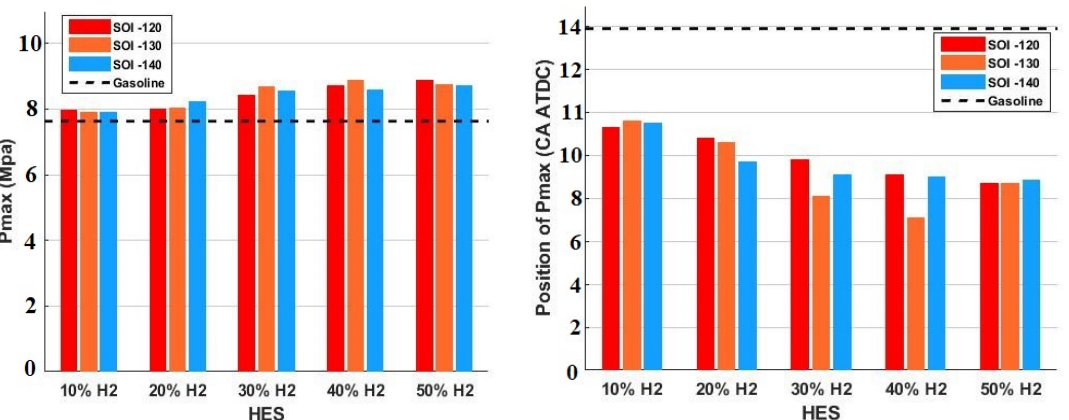
Figure 6. Effects of hydrogen direct-injection timing and HES on P MAX and position of P MAX.